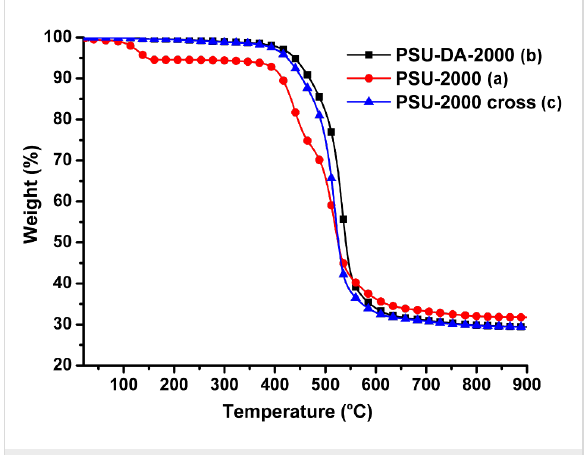
Figure 5: TGA thermograms of the precursor oligomers (PSU-2000) (a), and macromonomer, PSU-DA-2000 before (b), and after curing (PSU-DA-2000 X) (c).